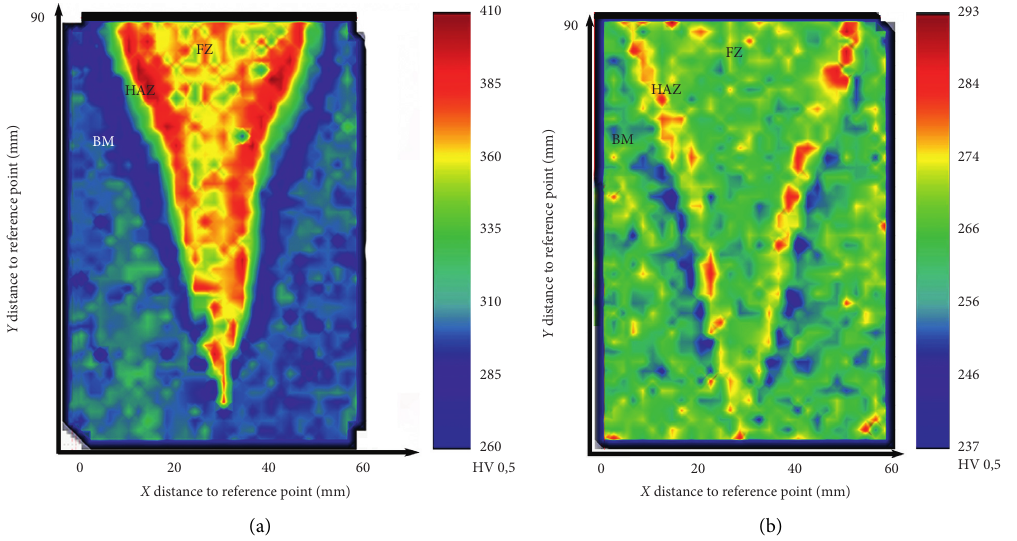
Figure 7: Hardness evolution in CA6NM EB welds without filler metal addition in (a) as-welded and (b) PWHTed